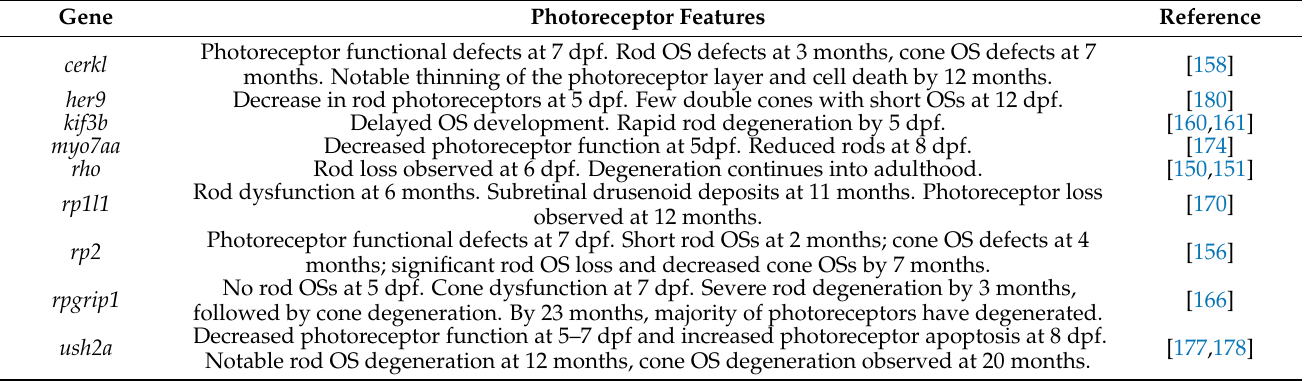
Table 4. Zebrafish mutant models of retinitis pigmentosa-like photoreceptor disease. Gene Photoreceptor Features